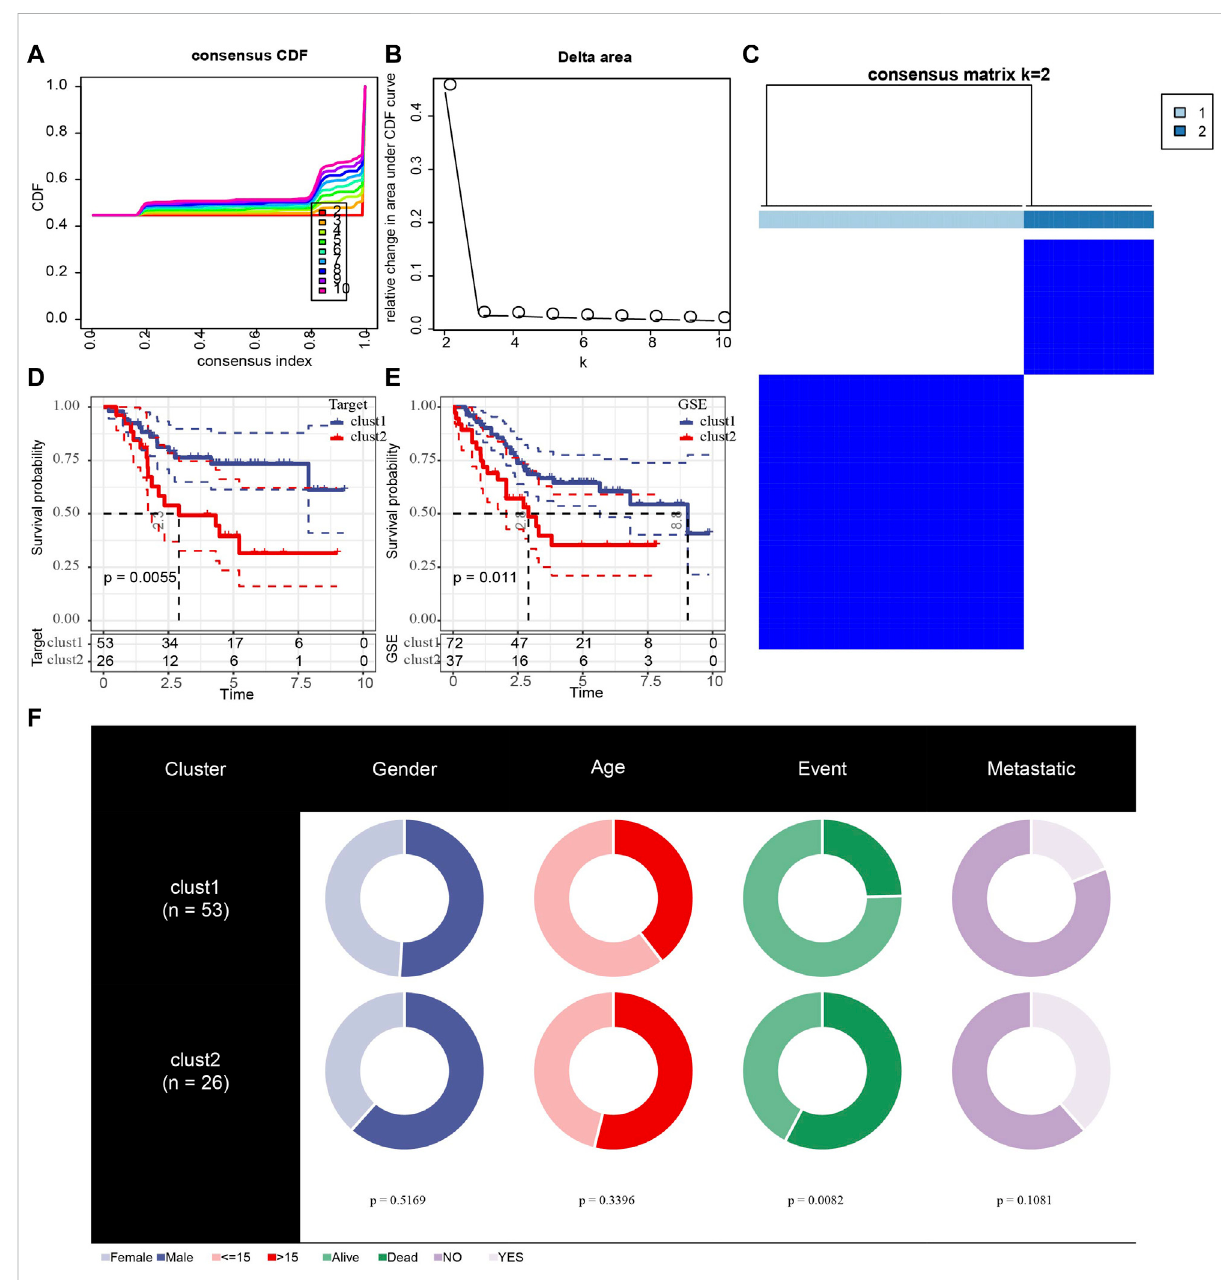
FIGURE 2 Identi fi cation of different metabolic molecular subtypes in osteosarcoma. (A) : The CDF curves of k at 2 – 10:00, respectively. (B) : Delta area curve of consensus clustering. (C) : consensus matrices for k = 2. (D) : The Kaplan Meier (KM) curve of cluster 1 and cluster 2 in the Target dataset. (E) : Survival analysis of two metabolic subtypes in merged GSE. (F) : Comparisons of clinicopathological features between cluster1 and cluster